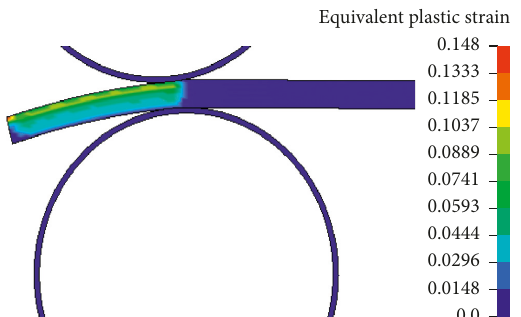
Figure 6: Distribution of equivalent plastic strain inside the plate with offset distance being 60mm.